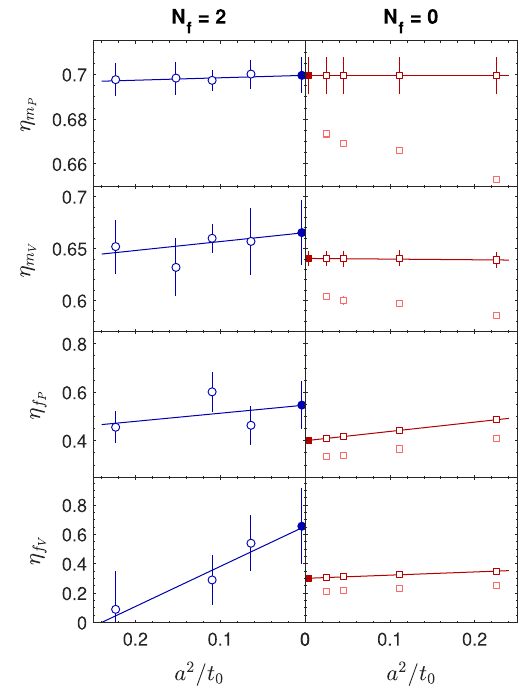
Fig. 5 Logarithmic derivative of the pseudoscalar and vector masses and decay constants with respect to the quark mass. Comparison between N f = 2 and N f = 0 theories. For the N f = 0 case, the values of ˜ η X , where the mass dependence of the scale is neglected, are shown in pink. When the scale dependence is taken into account, the ( 2 ) errors increase due to a dependence on η m P